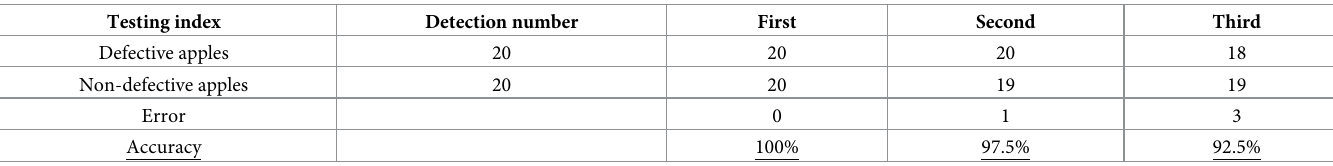
Table 1. Results of detection for apple